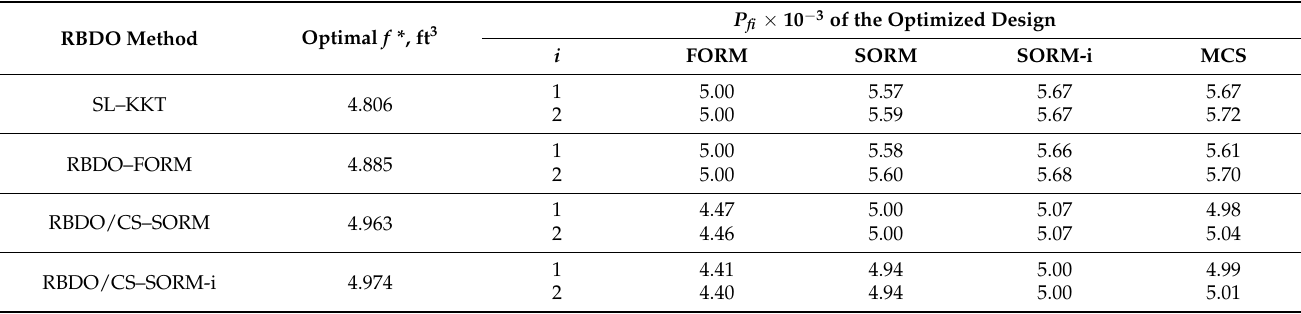
Table 15. Results of the RBDO/CS–SORM and SORM-i, RBDO–FORM, and SL–KKT for the truss cantilever structure. RBDO